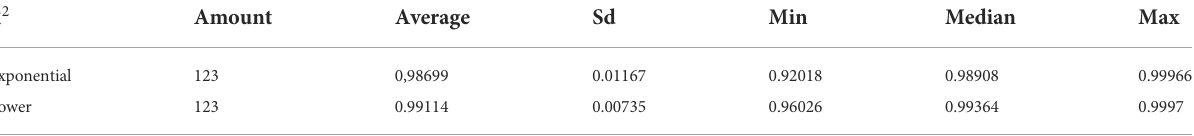
TABLE 3 Error analysis for power and exponential fi t of 123 cases.